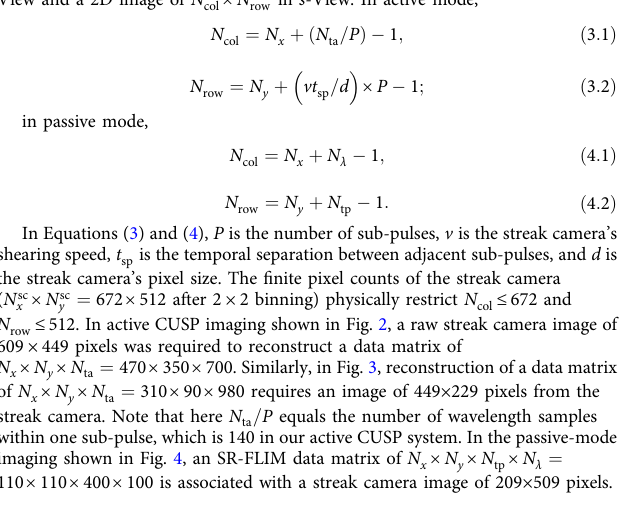
Supplementary Table 1. CUSP ’ s reconstruction of a data matrix of dimensions N x ´ N y ´ N ta